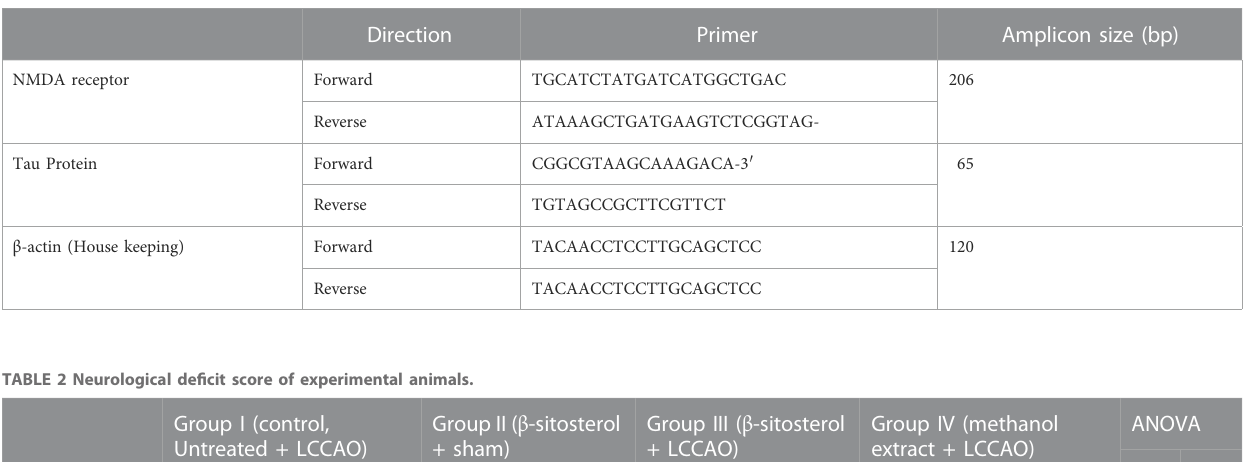
TABLE 1 Primer pairs used for quantitative RT-PCR analysis.